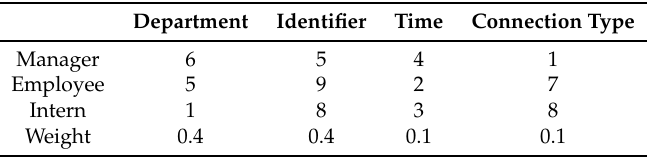
Table 7. Decision matrix and weights.